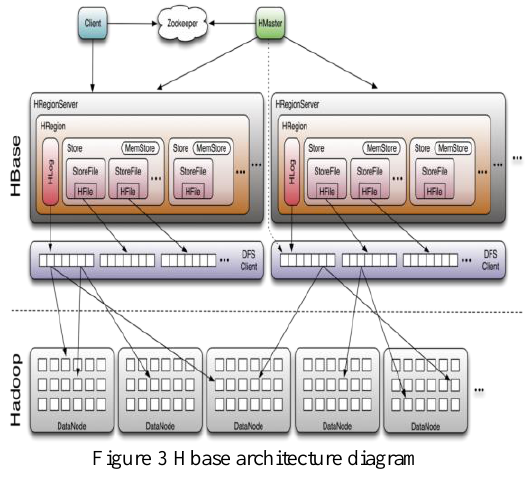
Figure 3 Hbase architecture diagram